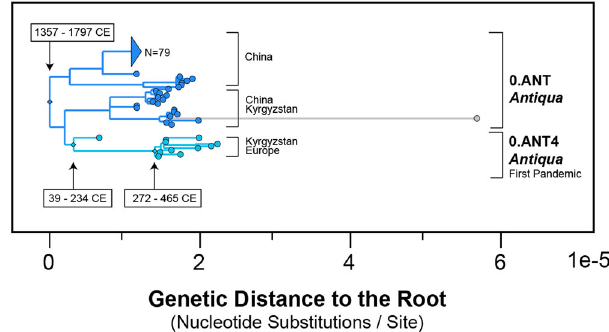
Fig. 3 Ancestor-descendant relationships in the maximum likelihood phylogeny reveal tMRCA con fl icts between Antiqua (0.ANT) and the First Pandemic (0.ANT4). Node dates (95% HPD) were estimated from the Bayesian analysis, where each population was assessed independently. Grey branches indicate outliers, as de fi ned by the 90% con fi dence interval of external branch lengths from all